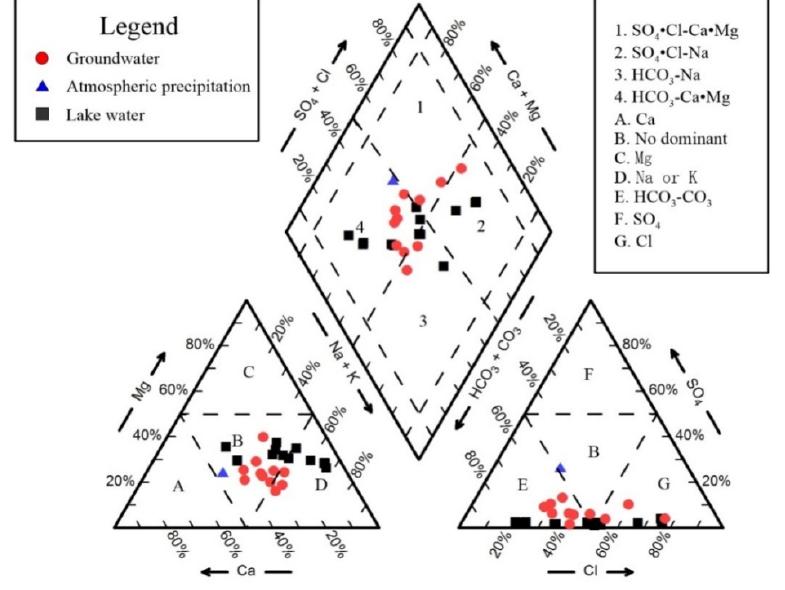
Figure 7. Piper Figure 7. Piper graph. Figure 7. Piper graph.